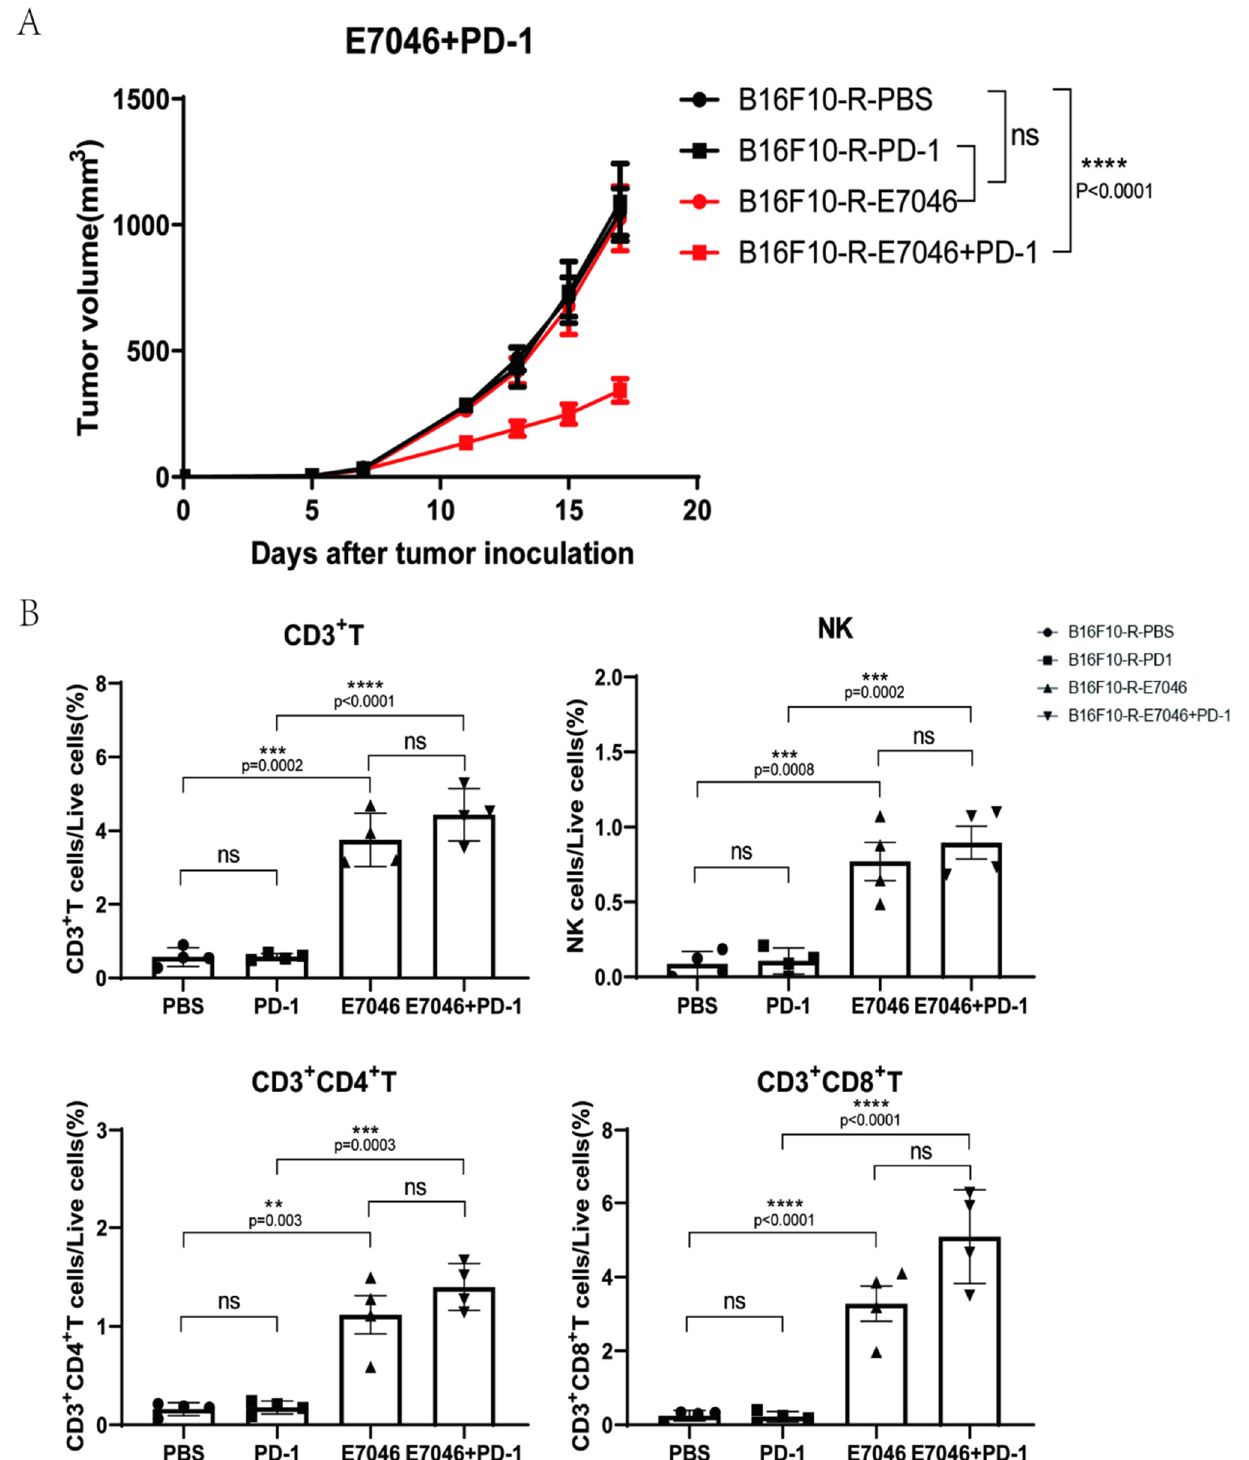
Figure 6. Effects of E7046 combined with pembrolizumab on B16F10-R tumour growth in vivo. ( A ) Growth curves of B16F10-R tumours in vivo treated with pembrolizumab, E7046, or PBS ( n = 6–8/group, two-way ANOVA test, Tukey). ( B ) Differences in the number of infiltrating lymphocytes in B16F10-R tumours treated with E7046 (one-way ANOVA test, Tukey); ns, not statistically significant; ** p < 0.01; *** p < 0.001; **** p < 0.0001.